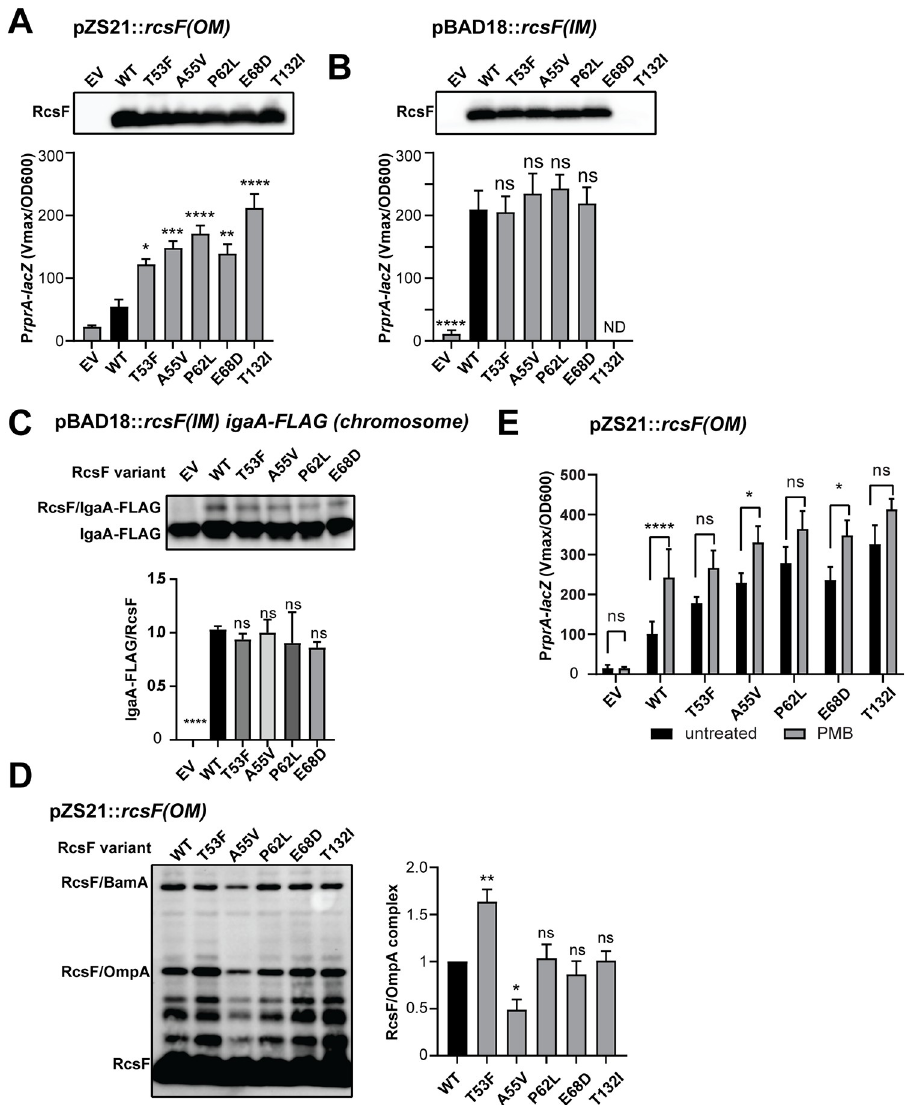
Fig 4. Characterization of RcsF GOF[OM] variants. GOF[OM] mutations were introduced on a plasmid encoding OM (A) or IM (B) versions of rcsF and analyzed by immunoblotting with α -RcsF antibodies and by a β -galactosidase assay using P rprA-lacZ transcriptional reporters. Graphs represent mean β -galactosidase activity normalized to OD600 +/- SD. (C) GOF[OM] mutations were introduced into the IM localized RcsF and tested for crosslinking to the chromosomally encoded IgaA-FLAG. The quantification of RcsF/IgaA-Flag band relative to the WT is shown below. Graphs represent mean of independent experiments +/- SD; n.s. = p � 0.05 (D) GOF[OM] mutations do not disrupt RcsF/OmpA crosslinking. Immunoblot analysis of in vivo formaldehyde crosslinked samples probed with α -RcsF antibodies (left). Immunoblot quantification of RcsF/OmpA relative to the WT (right). Graphs represent mean of three independent experiments +/- SD. (E) GOF[OM] variants were treated with 0.75 μ g/ml PMB for 40 min. Graphs represent mean β -galactosidase activity normalized to OD600, +/- SD. Significance throughout this figure is indicated in comparison to the WT as follows: n.s. = p � 0.05, � = p < 0.01, �� = p < 0.01, ��� = p < 0.001. ���� = p < 0.0001. ND = not determined. For additional analysis of data (E) S4 Table.